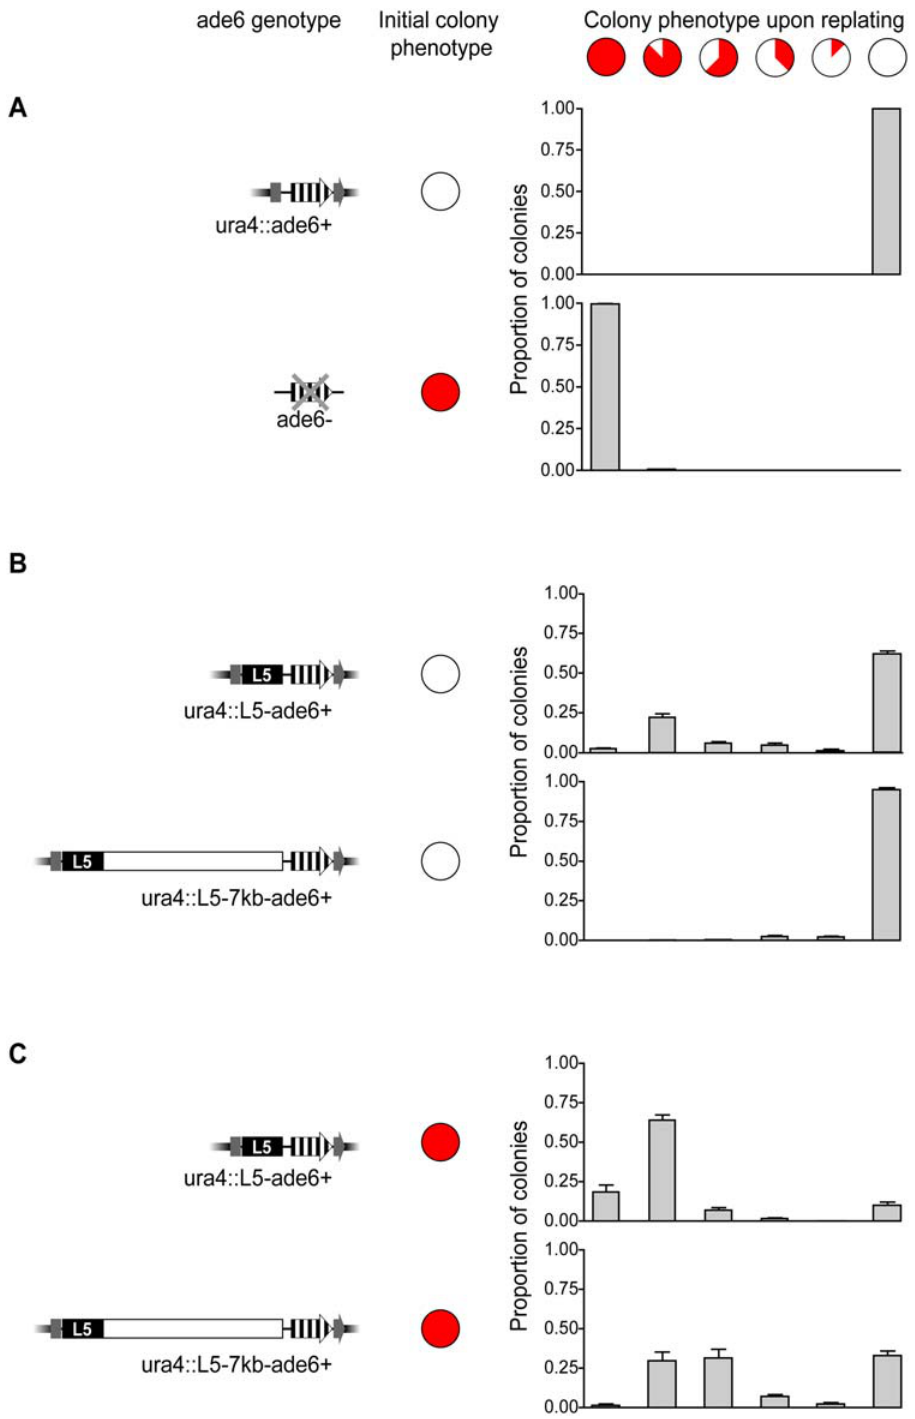
Figure 6. The extent and stability of ade6 + silencing is altered in spacer strains. (A–C) Colonies were selected on the basis of the initial colony phenotype (either all entirely red or entirely white) for each of the given genotypes. After a 24-hour period of growth, strains were re-plated and the phenotypes of the resultant colonies were scored and classified based on the proportion of the colony that exhibited silencing, as indicated schematically above the graphs. Intermediate silencing phenotypes included sectoring and homogenous, intermediate levels of pigmentation. The graphs below represent the proportion of colonies in each class based on genotype and initial colony color. doi:10.1371/journal.pgen.1000453.g006 Pnmt1- his3 + , the presence of genes can attenuate the spread of spreading through the sequence-dependent recruitment of other heterochromatin independent of the level of transcription (Figure mediating factors, such as transcription complexes, and dictate S5B). We conclude that DNA sequences modify heterochromatin whether a sequence behaves as a true barrier or falls in the range